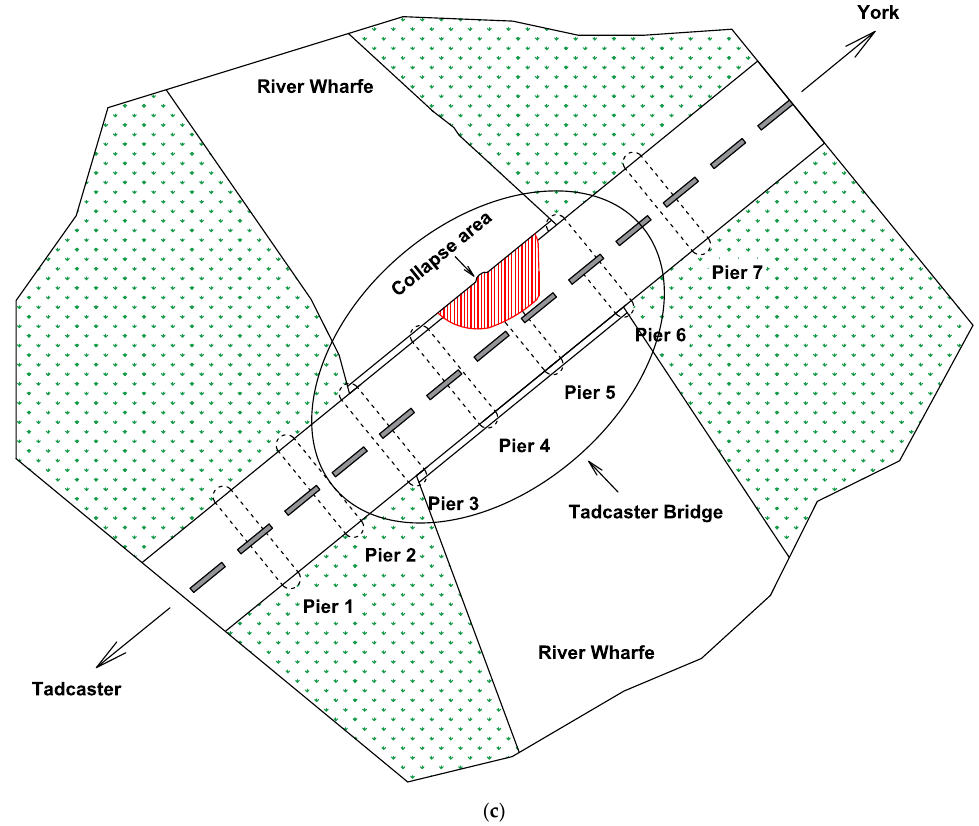
Figure 4. ( a ) The Tadcaster Bridge, ( b ) the image of the collapsed area [34] , ( c ) the plan view, pier labels, and collapse area. To analyze the deformation behavior in the period preceding collapse, 45 TerraSAR ‐ X Stripmap mode images (3 × 3 m ground resolution) taken prior to the collapse in the period from 9 March 2014 to 26 November 2015 were analyzed. The final acquisition in November was the last image available prior to the bridge collapse on 29 December 2015. These image acquisitions were taken at 11 ‐ day intervals, where possible. Based on the DInSAR methodology and Small Baseline Subset (SBAS) technique, a small set of 45 dis ‐